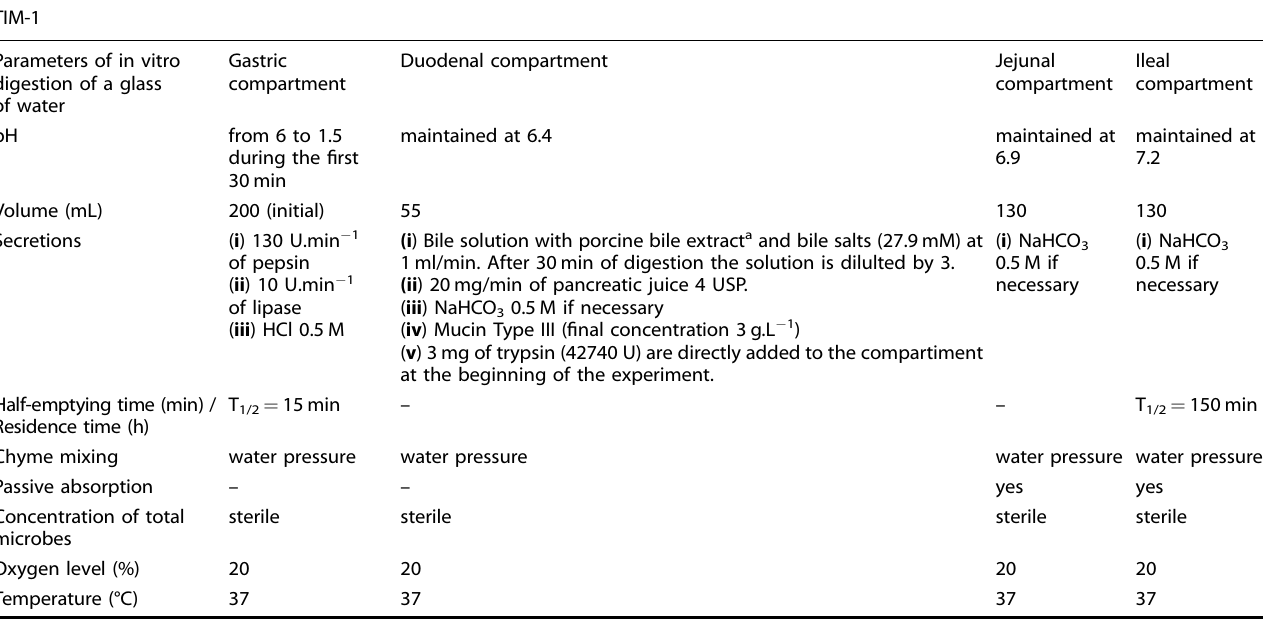
Table 2. Parameters of the TIM-1 system when simulating digestive conditions of a healthy adult after intake of a glass of Volvic water.